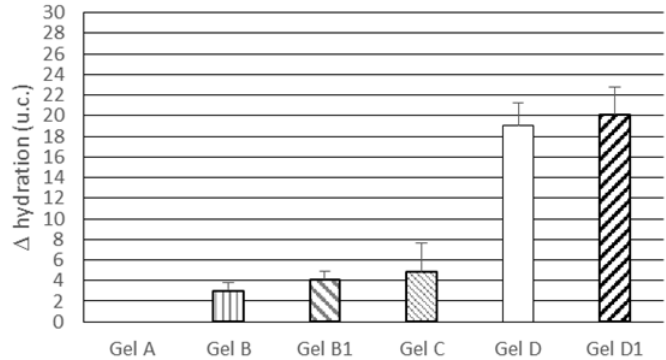
Figure 5. Skin hydration difference (Δ hydration) between baseline values and values recorded after a one-week treatment with the gels under investigation. Statistically significant differences ( p < 0.05) were observed for the following comparisons: all gels vs. gel A; gel D vs. gels B, B1 and C; gel D1 vs. gels B, B1 and C.